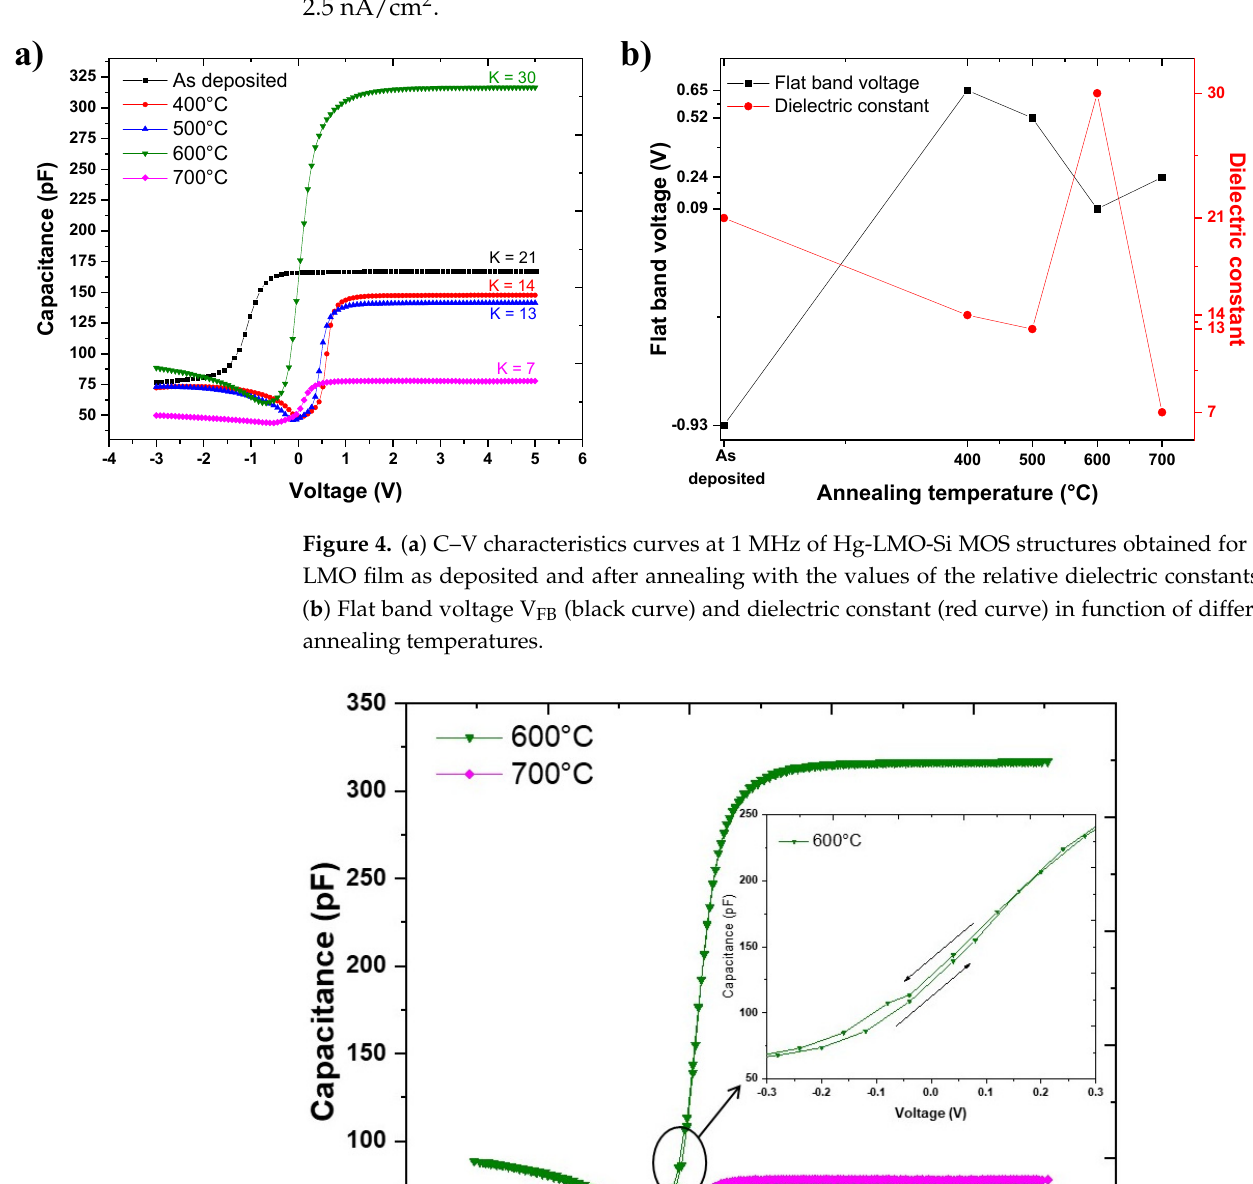
Figure 5. Capacitance-voltage hysteresis measurements at 1 MHz of the LMO film after annealing at 600 and 700 °C respectively. Inset: zoom-in on the C–V of the LMO film after 600 °C showing the small hysteresis loop.